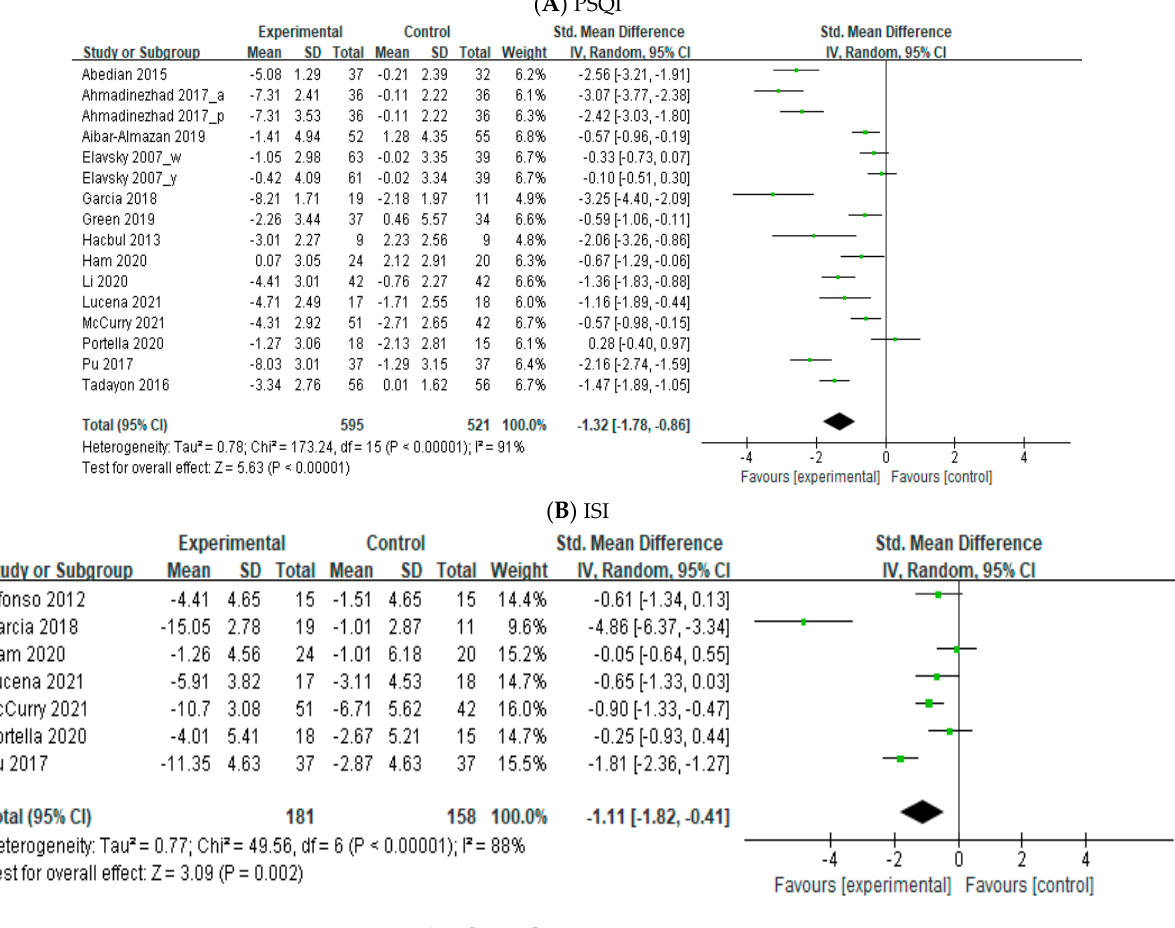
Figure 2. Forest plots [26–40] Table 2. Modulator Analyses of Nonpharmacological Intervention in Perimenopausal Women with Sleep